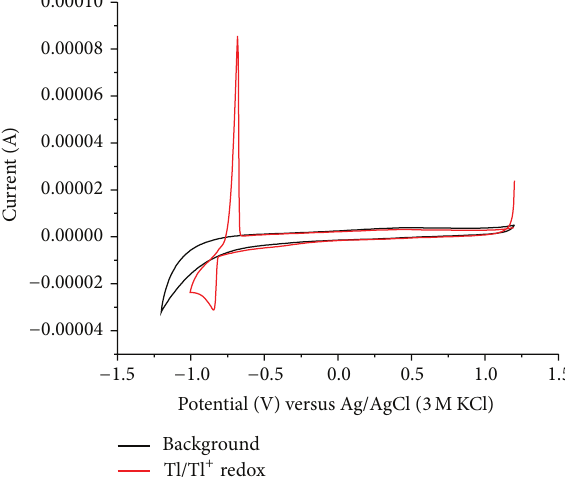
Figure 10: Cyclic voltammograms of glassy carbon electrode in the presence (red) and absence (black) of 1mM TlSO 4 in deaerated 0.5 M H 2 SO 4